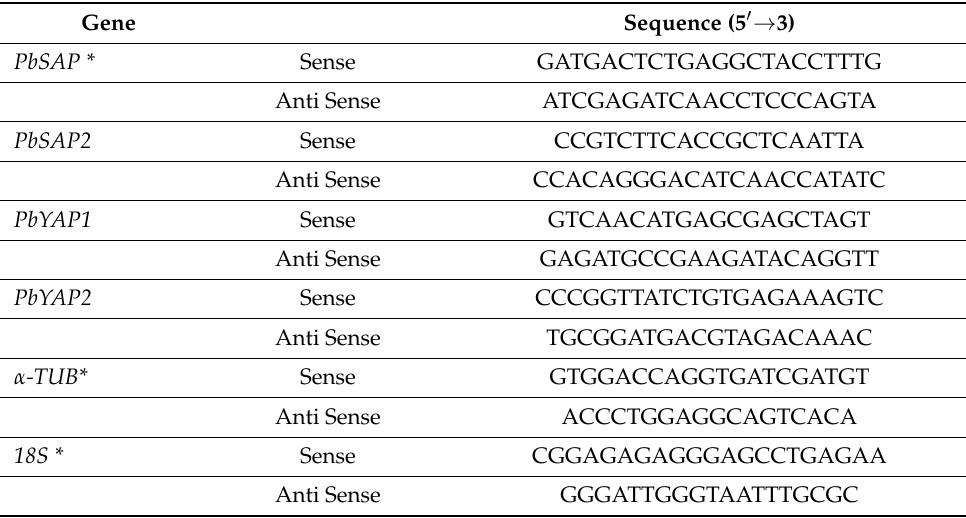
Table 1. Oligonucleotides used for real-time quantitative PCR analysis.